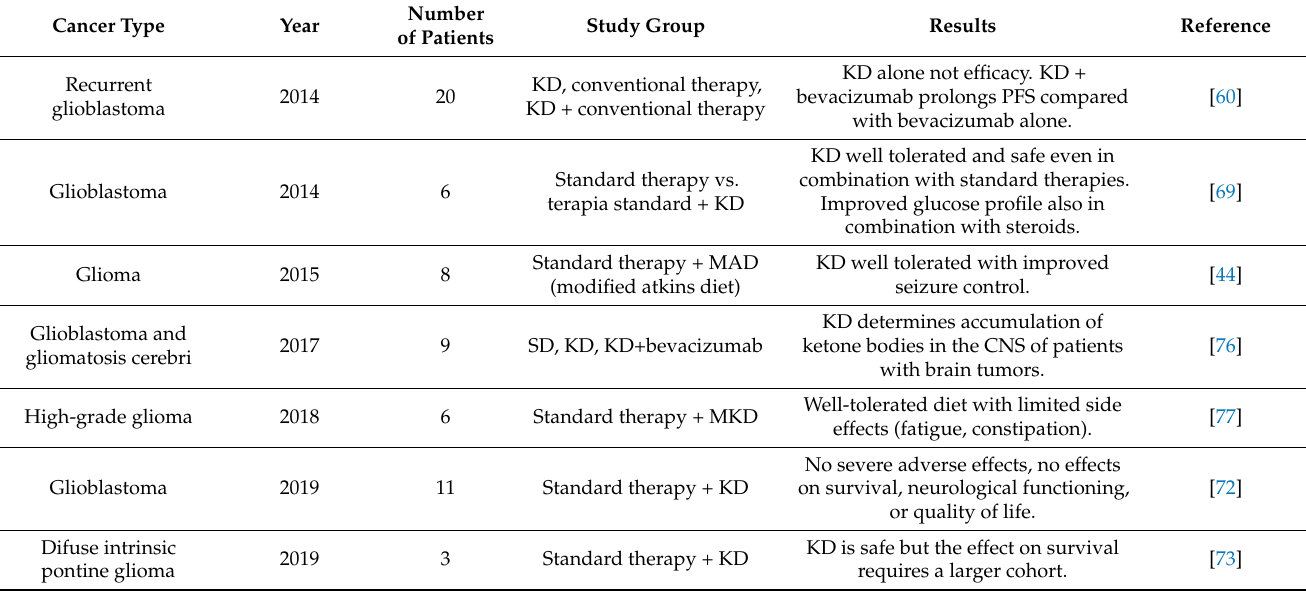
Table 2. The main clinical studies on the use of KD in CNS